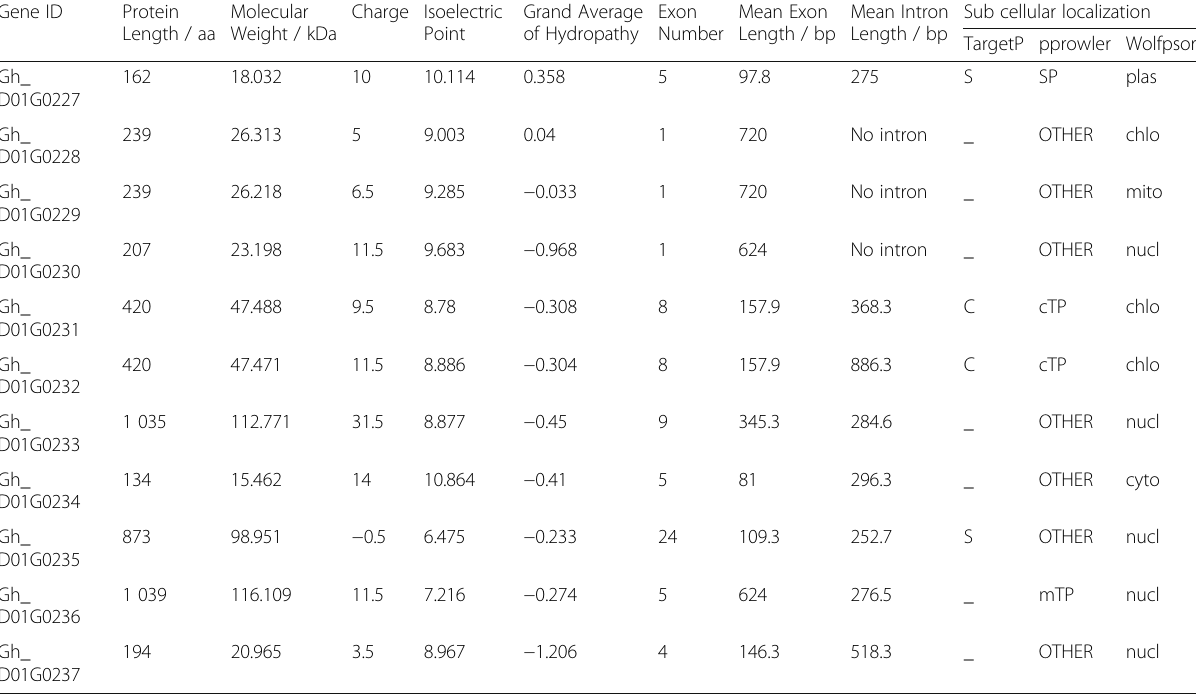
Table 3 Physiochemical properties and sub cellular localization prediction of the mined genes within the major clusters of the consistent QTLs